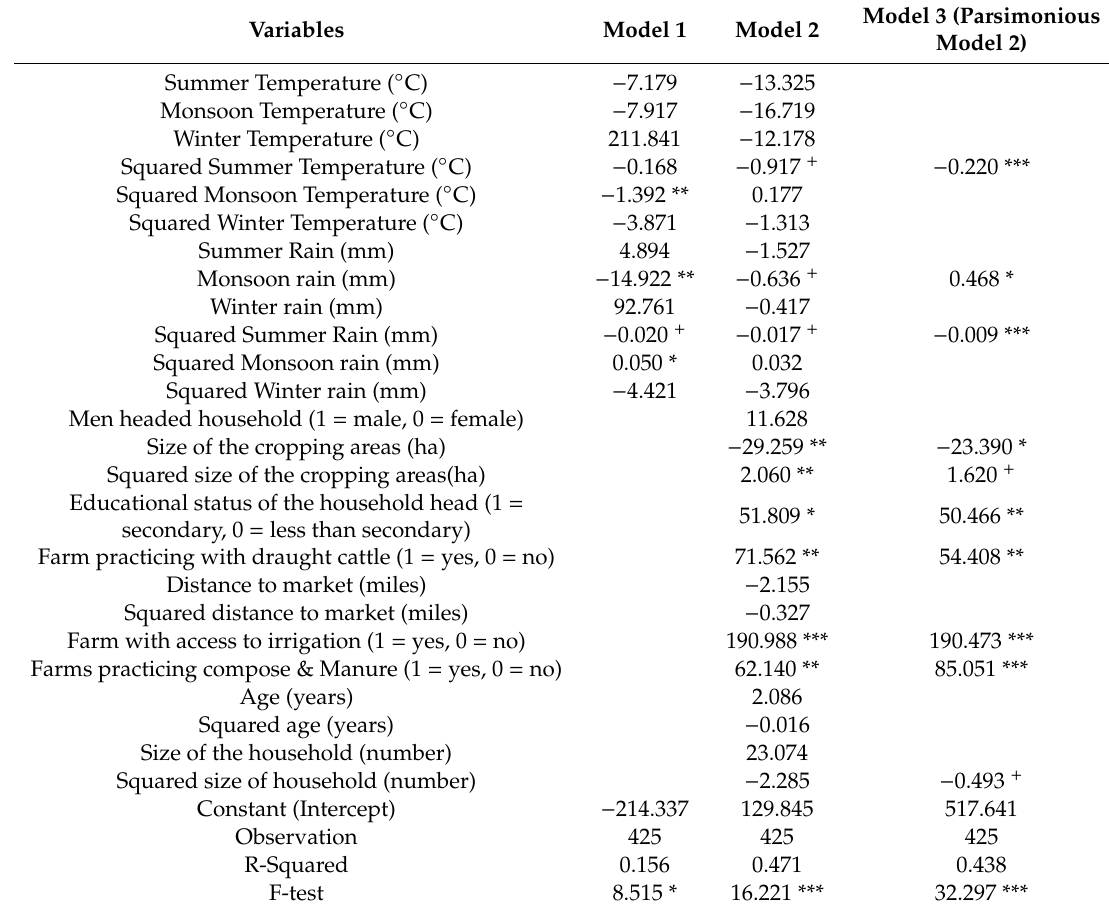
Table 2. Determinants of net farm revenue per hectare ($ ha − 1